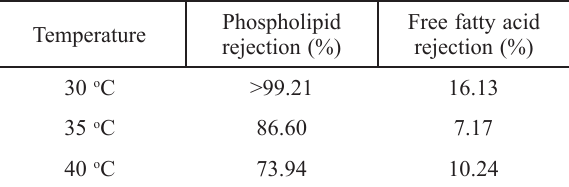
Table 4 – Rejection of phospholipid and fatty acids at vari- ous feed temperatures at a pressure of 1 bar and CPO